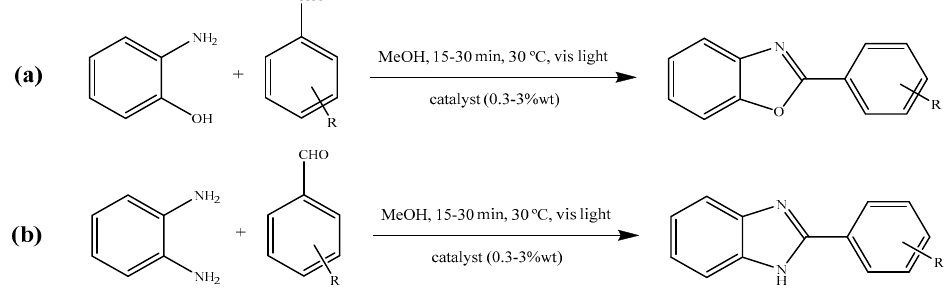
Figure 9. ( a ) Synthesis of 2 ‐ arylbenzoxazoles; ( b ) synthesis of 2 ‐ arylbenzimidazoles. The synthesized 2 ‐ arylbenzoxazoles and 2 ‐ arylbenzimidazoles were characterized by proton and carbon ‐ 13 nuclear magnetic resonance ( 1 H ‐ NMR and 13 C ‐ NMR, respectively) at the Laboratorio de Técnicas Instrumentales at Universidad de Valladolid (Valladolid, Spain) using an RMN 500 (Agilent Technologies, Santa Clara, CA, USA), in